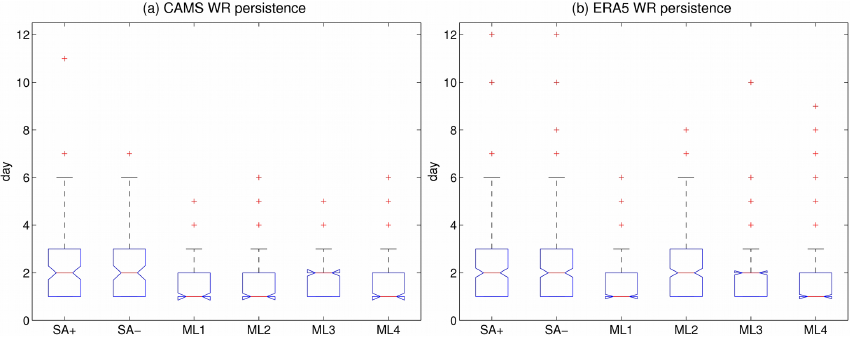
Figure 5. WR persistence in (a) CAMS and (b) ERA5 classifications, displayed as the distribution of the WR sequences. Red lines represent the median, boxes represent the interquartile range, whiskers extend up to 1.5 times the interquartile range, and outliers are displayed as red crosses.